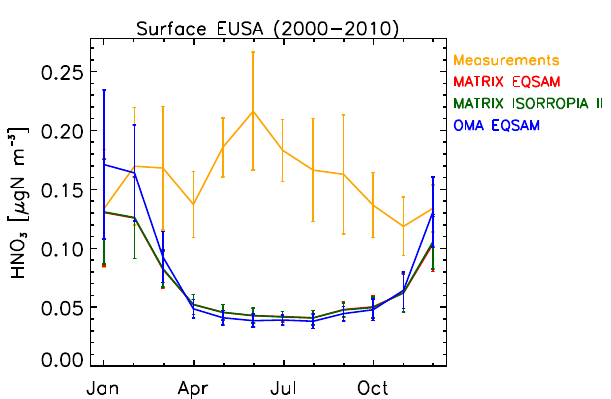
Figure A1. The 2000–2010 HNO 3 mean annual cycle over EUSA (right), error bars represent ± 1 standard deviation. Measurements are in orange, MATRIX-EQSAM is in red, MATRIX-ISORROPIA II is in green, and OMA-EQSAM is in